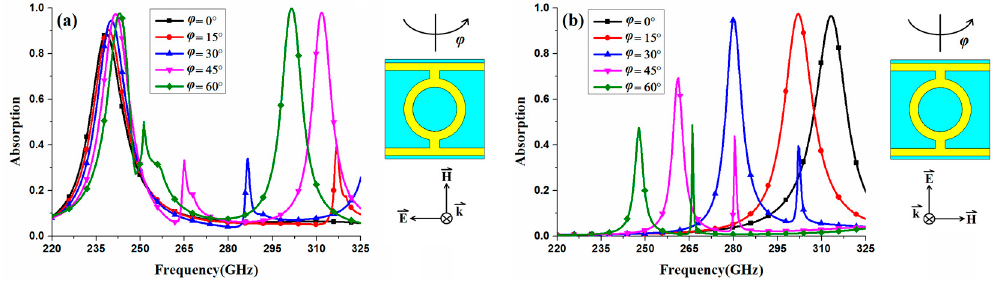
Figure 7. Simulated absorption spectra of absorber for different incident angles for ( a ) the TE-polarized incident wave and ( b ) the TM-polarized incident wave.